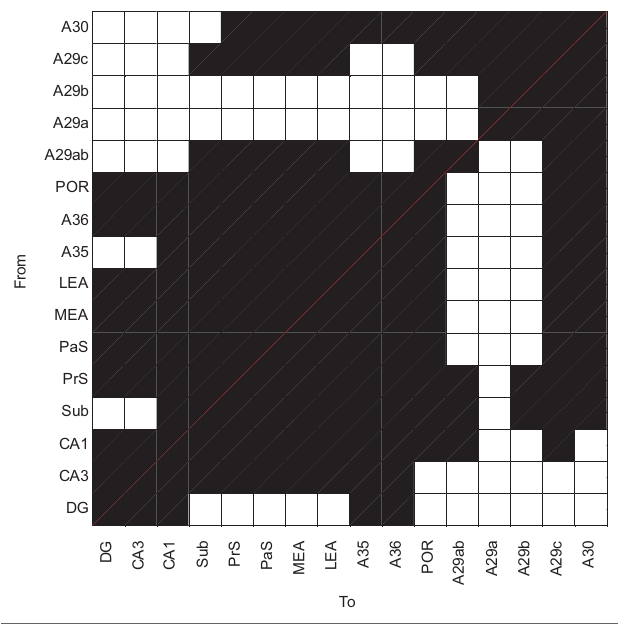
Table 2 | Anatomical connections between subareas of the hippocampal formation, the parahippocampal region and the retrosplenial cortex.